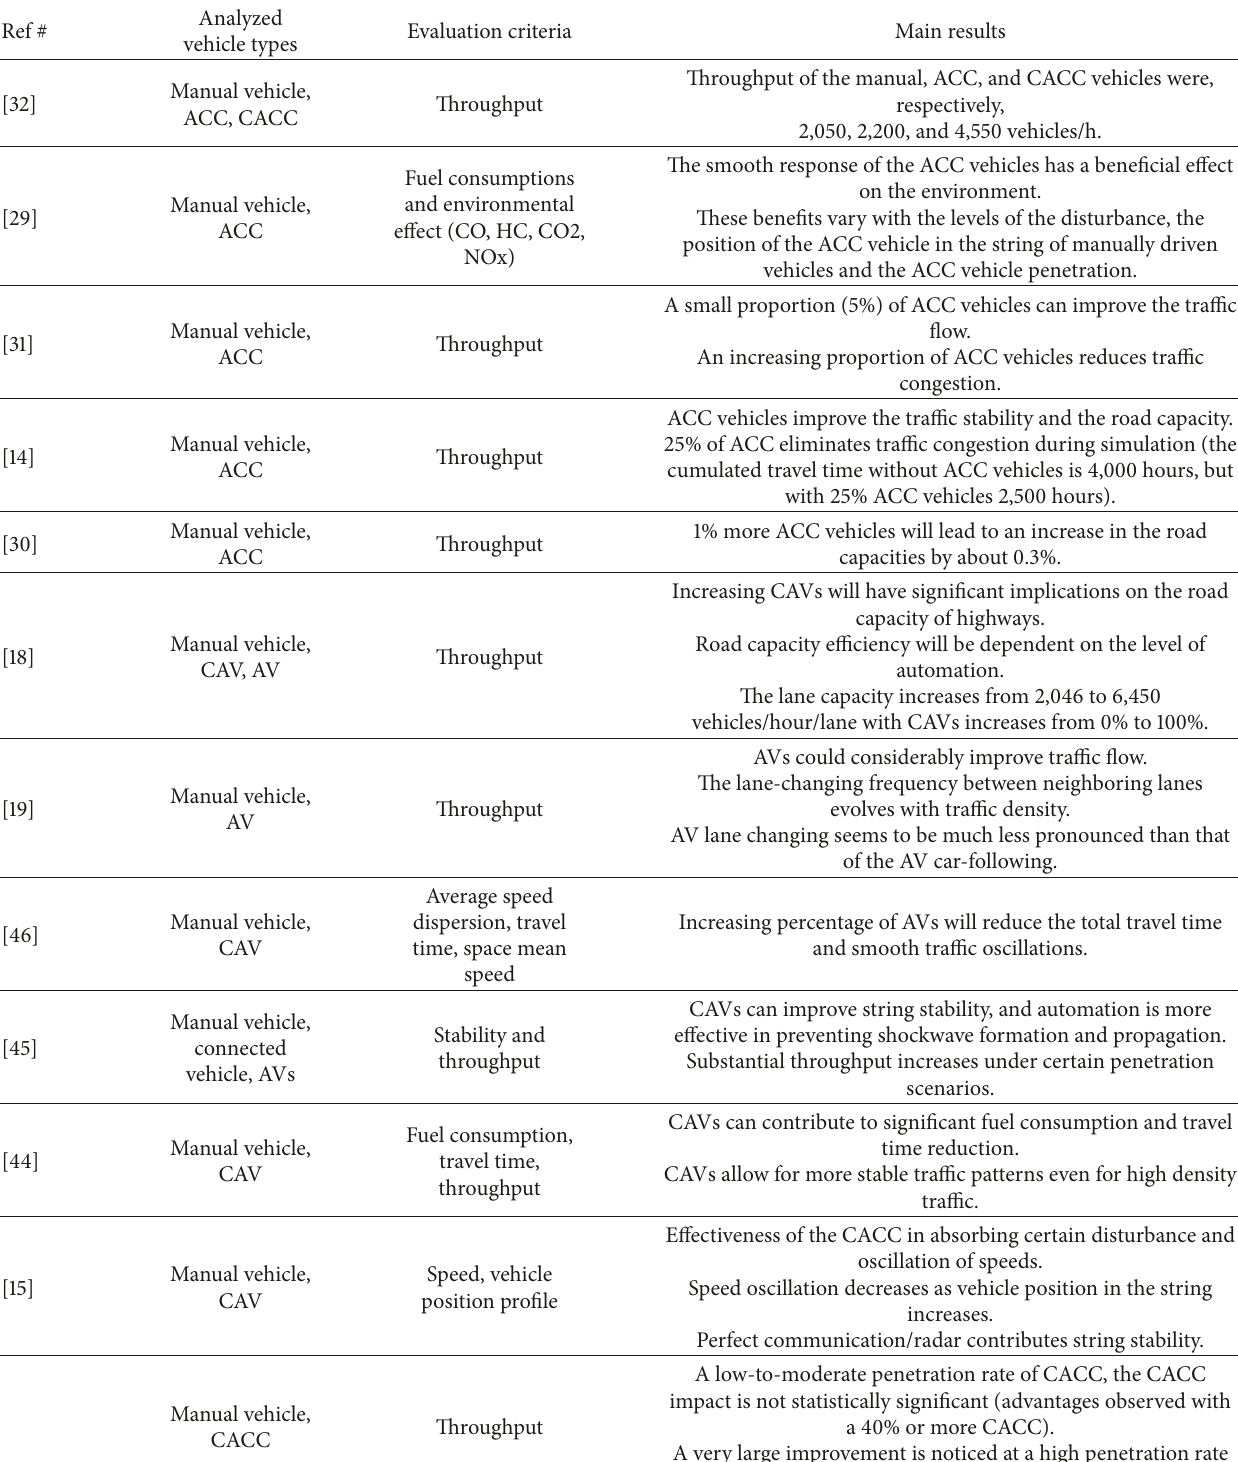
Table 2: Simulation-based intelligent-vehicle studies: analyzed vehicle types, evaluation criteria, and main